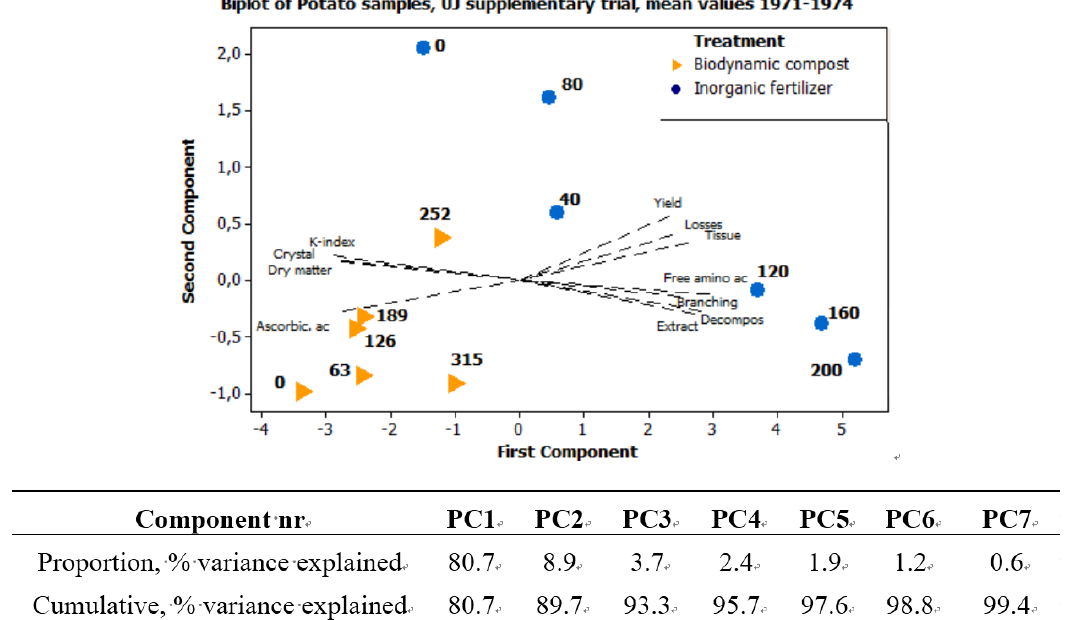
Figure 5. PCA plot of mean values from potato samples are made into manure with different amounts of fertilizers, in the additional UJ trial 1971–1974. Bolded numbers indicate amounts of nitrogen applied, kg